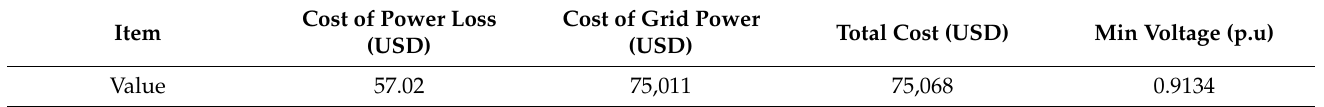
Table 1. Numerical results of base 33-bus distribution network for 24 h.